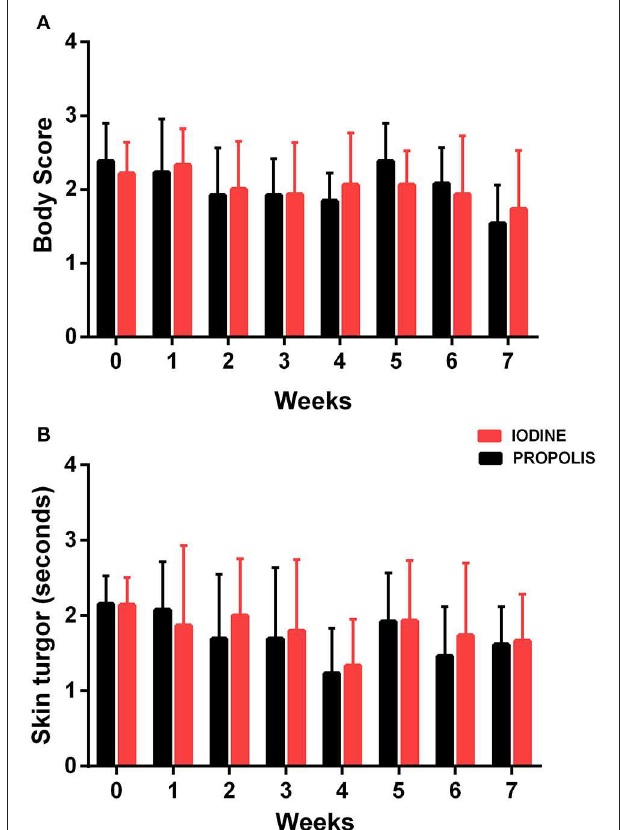
FIGURE 4 | Determination of (A) body condition score and (B) time of return of skin turgor in experimental animals. Results are presented as mean at each observation time for each group, and bars indicate their respective standard deviations. There were no statistical differences by the Student t -test ( p < 0.05) for any of the observation